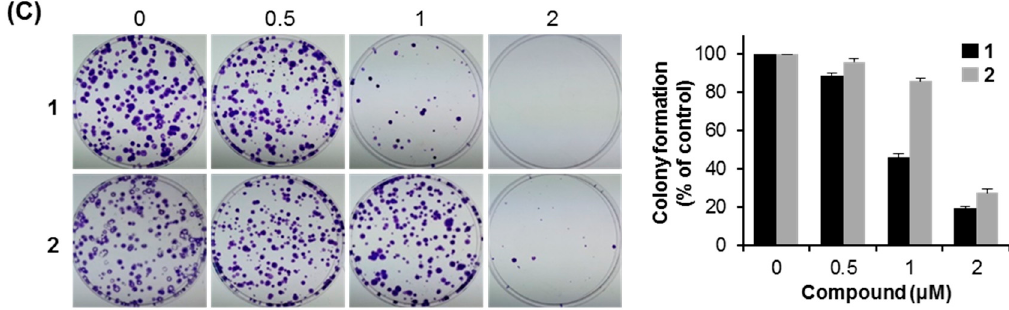
Figure 6. Inhibitory effects of compounds 1 and 2 on colony formation capacity of human cancer cells. The colony formation assays of MCF7 ( A ); A549 ( B ); and HCT116 cells ( C ) treated with compounds 1 and 2 at the indicated concentrations for two weeks. Data presented are mean ± SD from three independent observations.